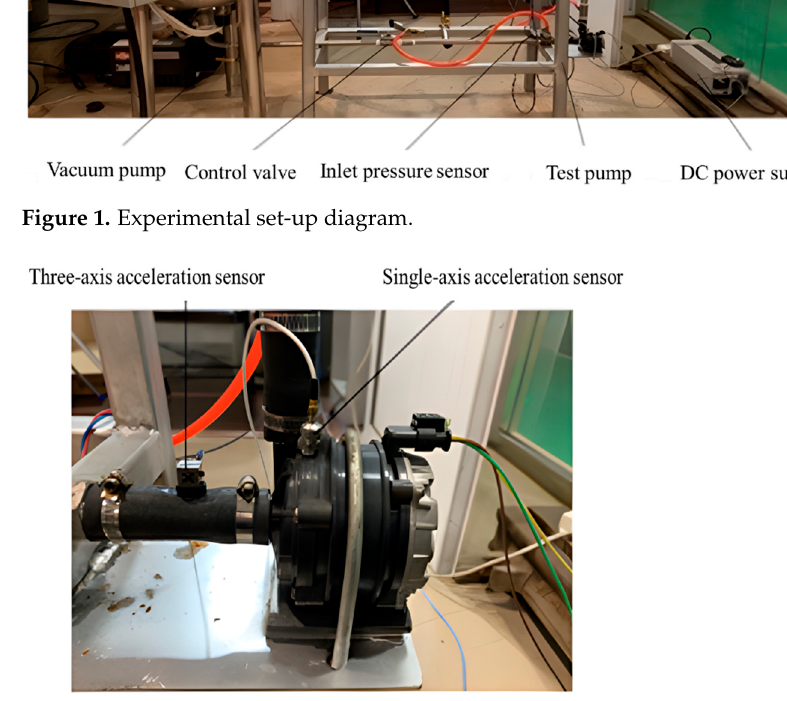
Figure 2. Sensor arrangement diagram.